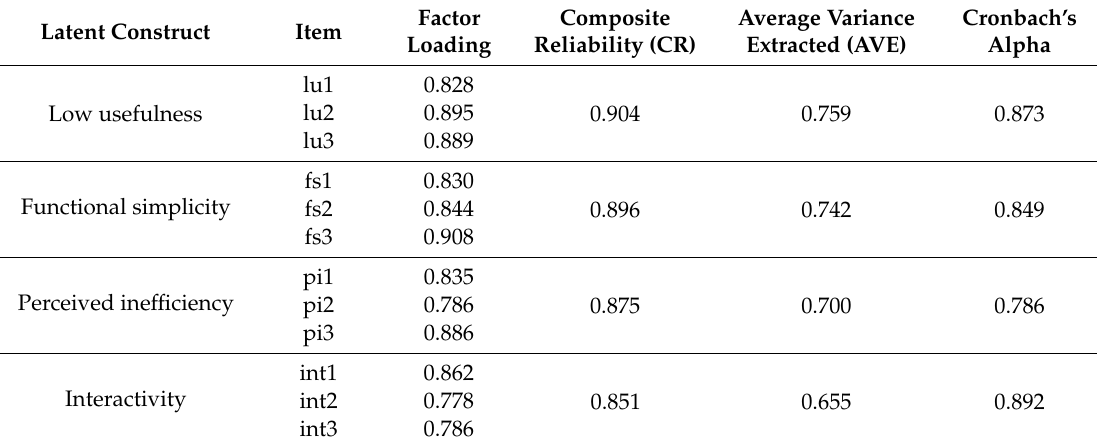
Table 4. Results for reliability and convergent